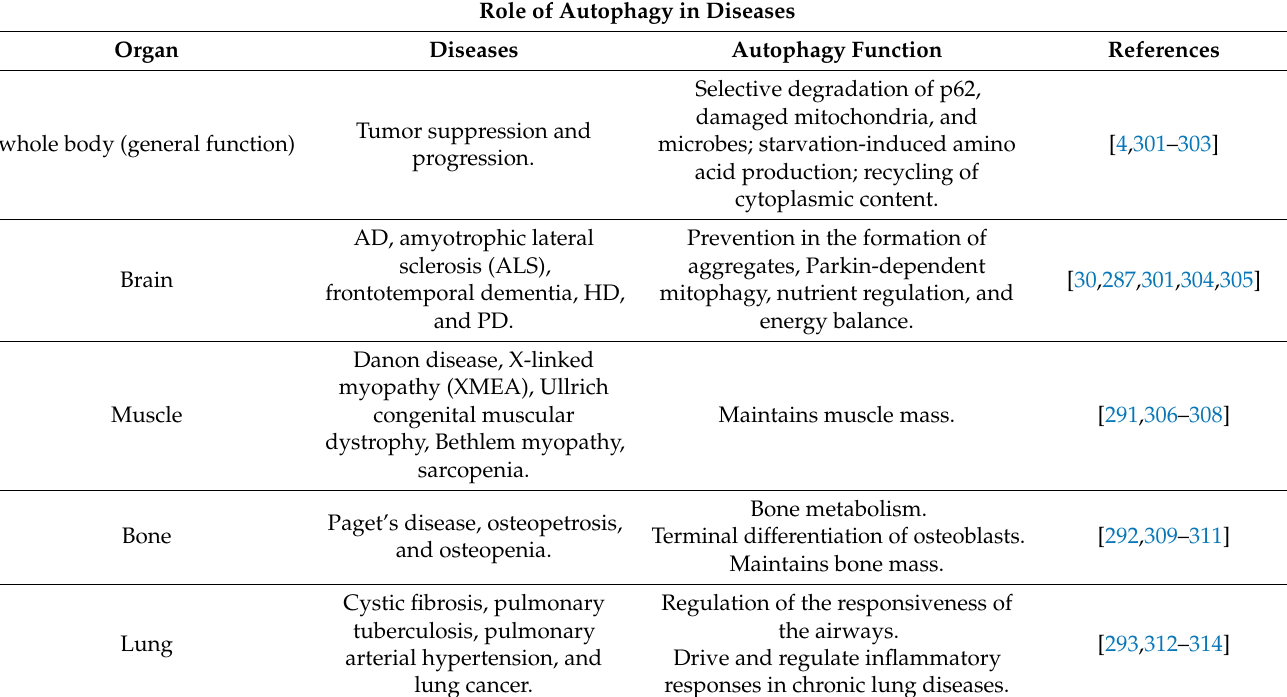
Table 4. Diseases related to